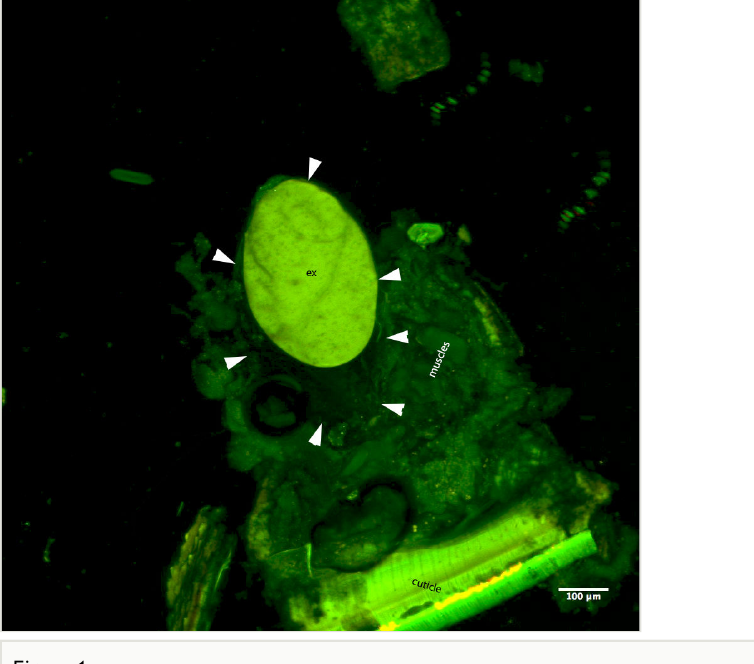
CLSM volume rendered micrograph showing the cyanide gland of Oxidus gracilis (arrows pointing the wall of the cyanide gland, ex=strongly auto fl uorescing gland